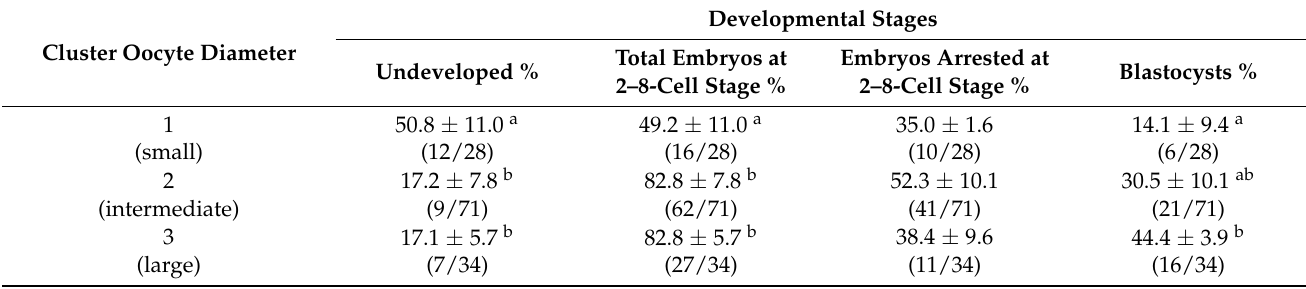
Table 5. Mean values of different developmental stages by clustering of morphometric parameters of oocytes by oocyte diameter.